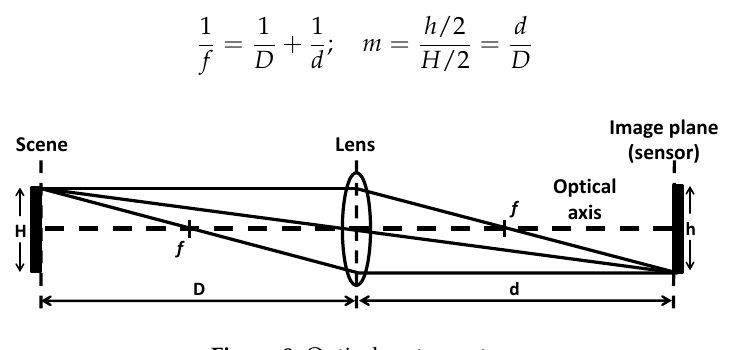
Figure 8. Optical system setup.